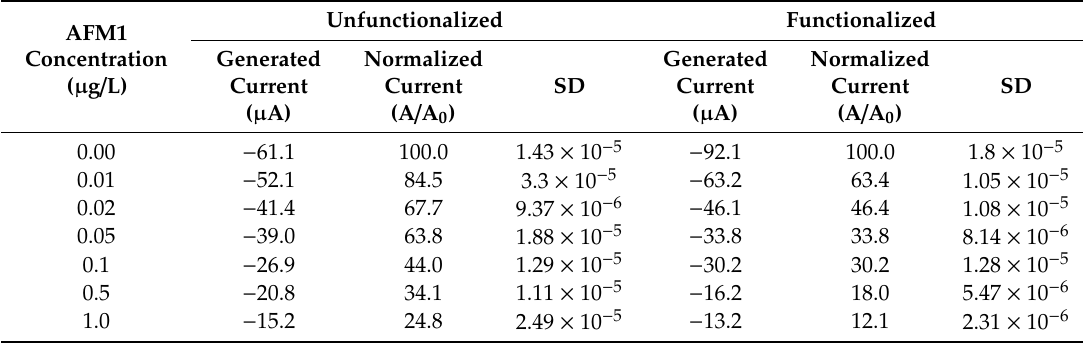
Table 2. Sensor response for AFM1 standards using spiked milk sample for unfunctionalized (without SWCNTs) and functionalized (with SWCNTs) sensors. Unfunctionalized AFM1 Concentration